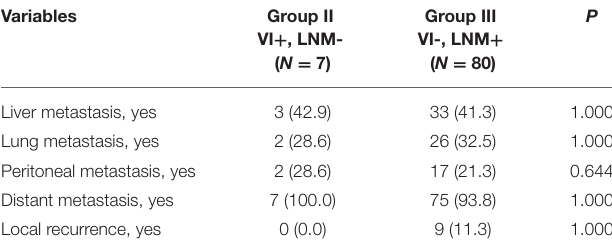
TABLE 5 | Recurrence types of recurrent patients in groups II and III.